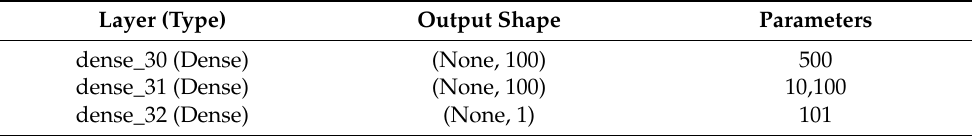
Table 7. A summary of the saved model that was reloaded for use with new data. Layer (Type)